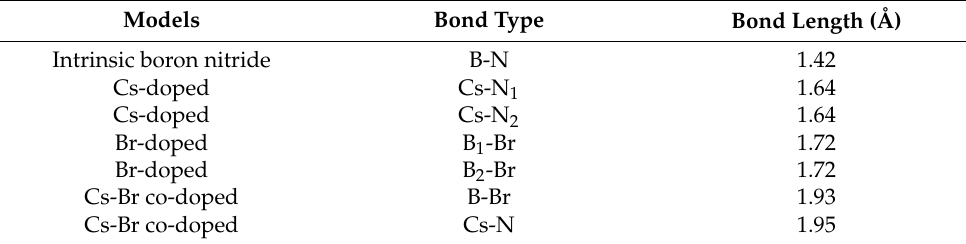
Table 1. Bond lengths of Cs-N, B-Br, and B-N in different models.